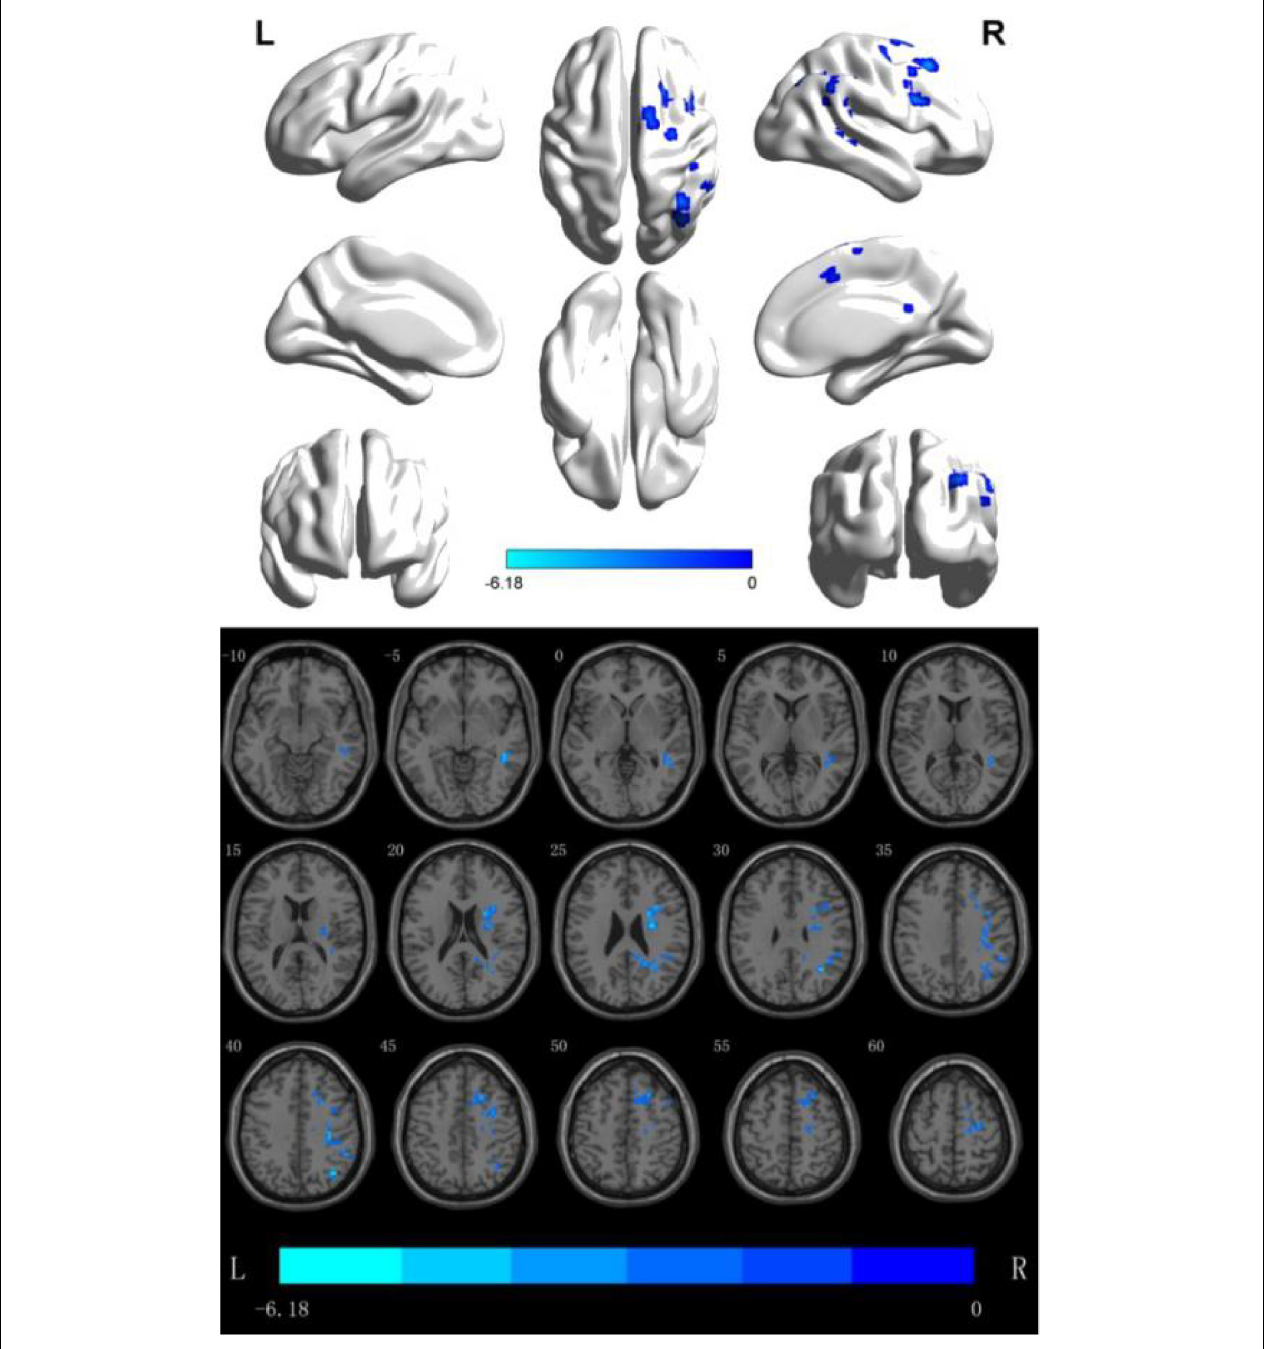
FIGURE 1 | fALFF analysis of the difference between the two groups before and after treatment. The blue area is the brain area where activation is inhibited (threshold: individual level P < 0.05, clump level P < 0.05).